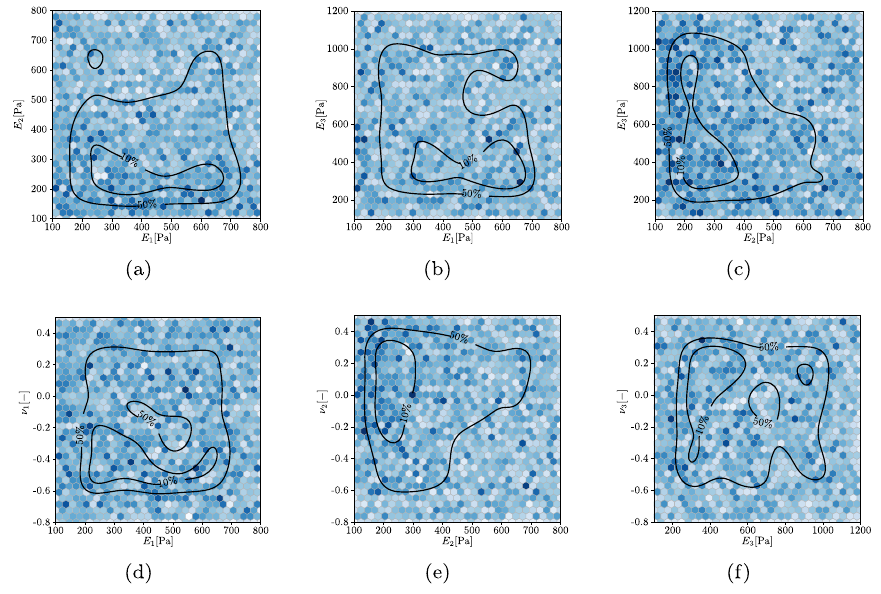
Fig. 14 Hexagonal histograms (high weight in dark blue) for marginals for selected pairs of parameters in heterogeneous example with uncertain inflow condition and added Gaussian noise. Percentile lines of KDE approximations in